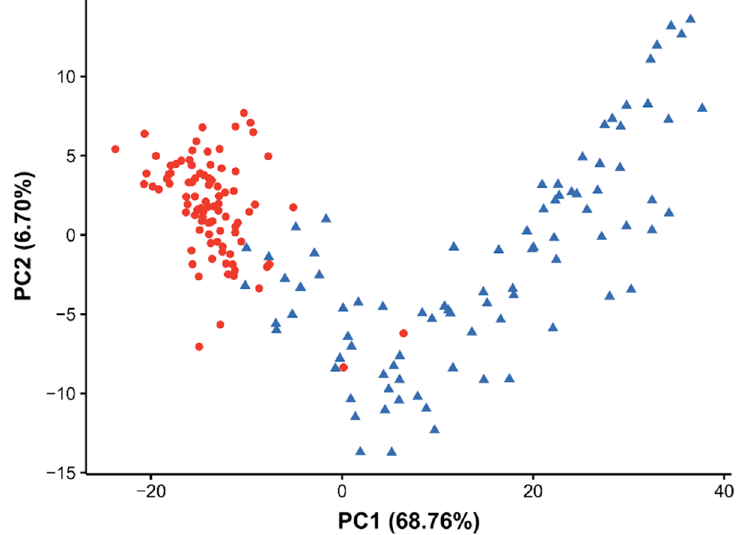
Figure 7. The PCA scores plot from analysis of the DESI-MS dataset of the control Daphnia magna eggs (blue triangles) relative to those that were exposed to 5 mg/kg bisphenol-A for 48 h (red circles). The exposure period started immediately after the sixth adult brood. Each point relates to a single pixel from a DESI-MS ion image of a D. magna egg.